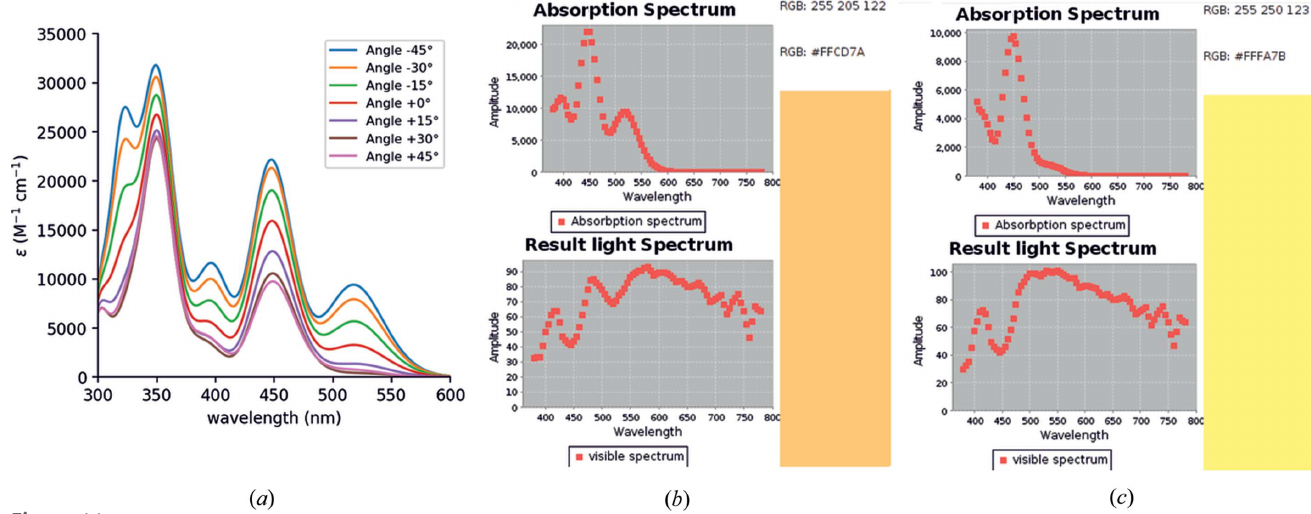
Figure 11 ( a ) Calculated absorption spectra of the dimer as a function of the photon polarization axis. ( b ) Perceived colour for the polarization axis at (cid:7) 45 (cid:4) against the b -crystallographic direction in the (001) plane (orange–red). ( c ) Perceived colour for the polarization axis at +45 (cid:4) (yellow). The crystallographic and polarizer directions are the same as in Fig. 5.